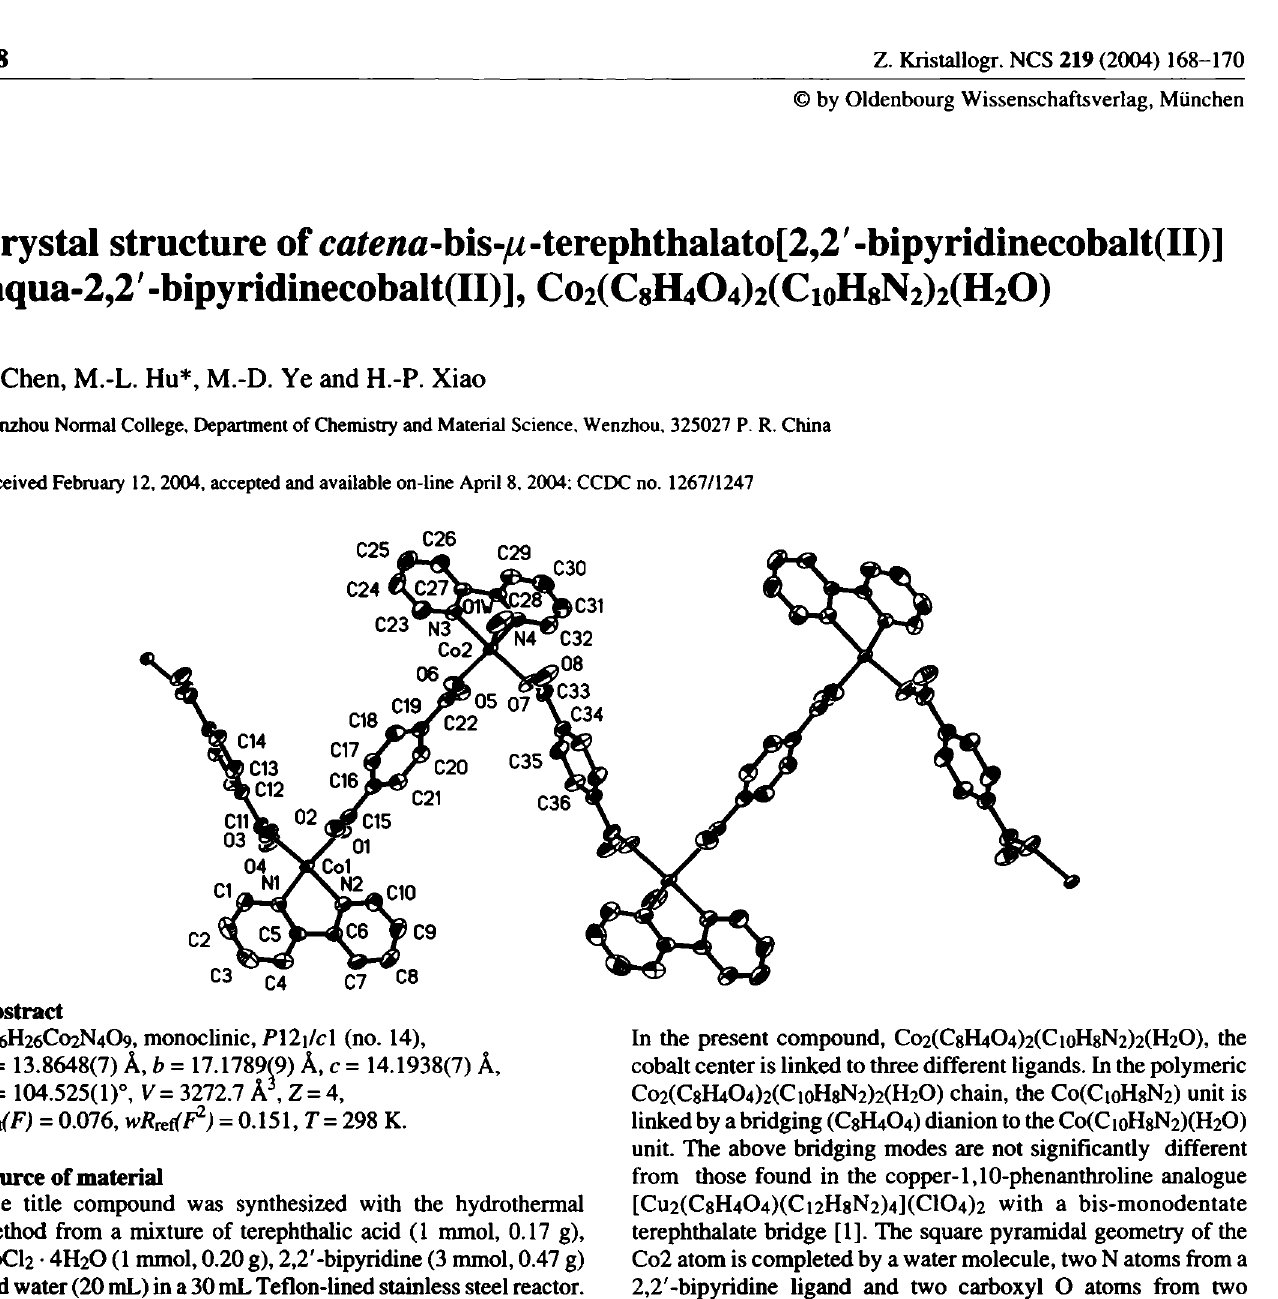
Table 1. Data collection and handling.